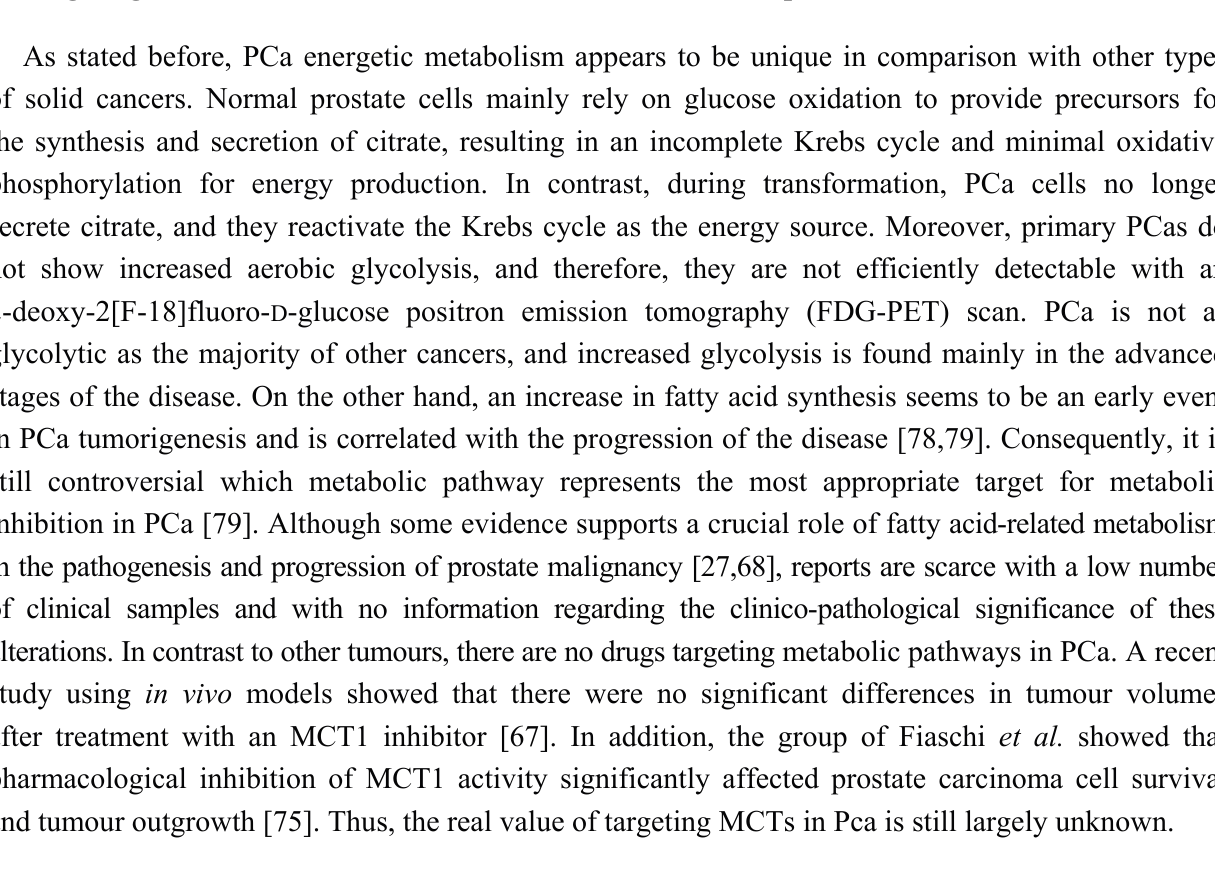
Figure 3. Schematic representation of the lactate shuttle system between malignant cells and cancer associated fibroblasts (CAFs). The expression of MCT4 in CAFs together with the expression of MCT1 in tumour cells is associated with biochemical recurrence after surgery and the pT3 stage of the tumour. Adapted from